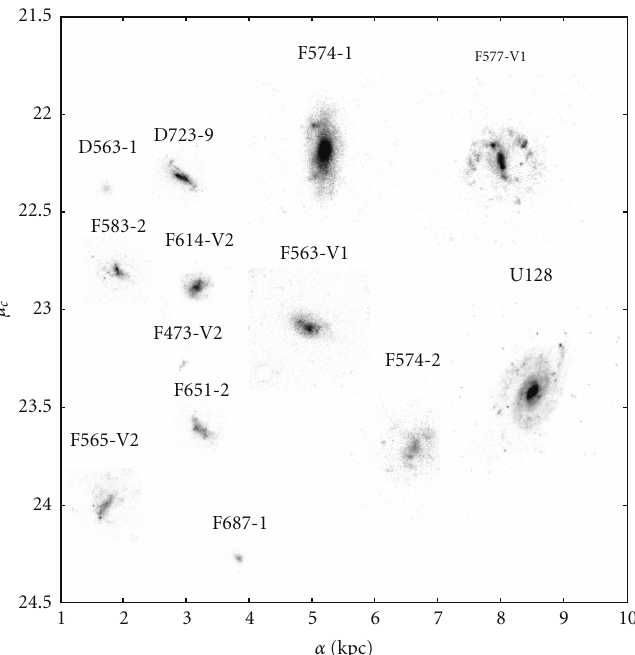
Figure 6: Galaxy morphology as a function of central surface brightness ( μ c ) and scalelength ( α ). This panel displays galaxies with scale- engths greater than 1kpc. Flocculate spiral patterns are evident for the larger LSB galaxies. A larger version of this figure is available at our website.